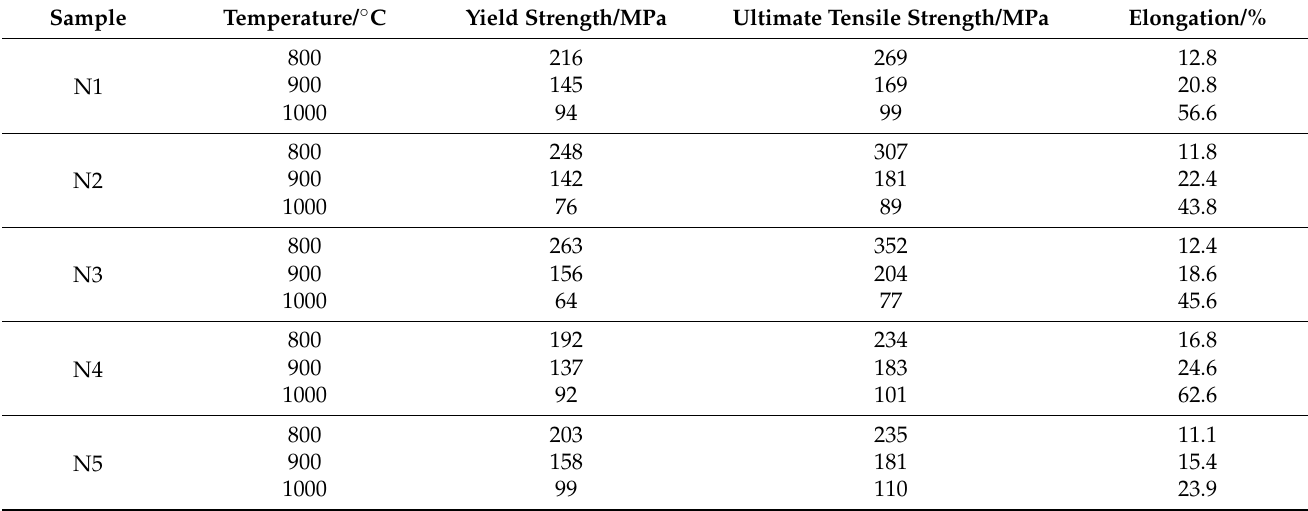
Table 4. Tensile properties of the laminated composites at elevated